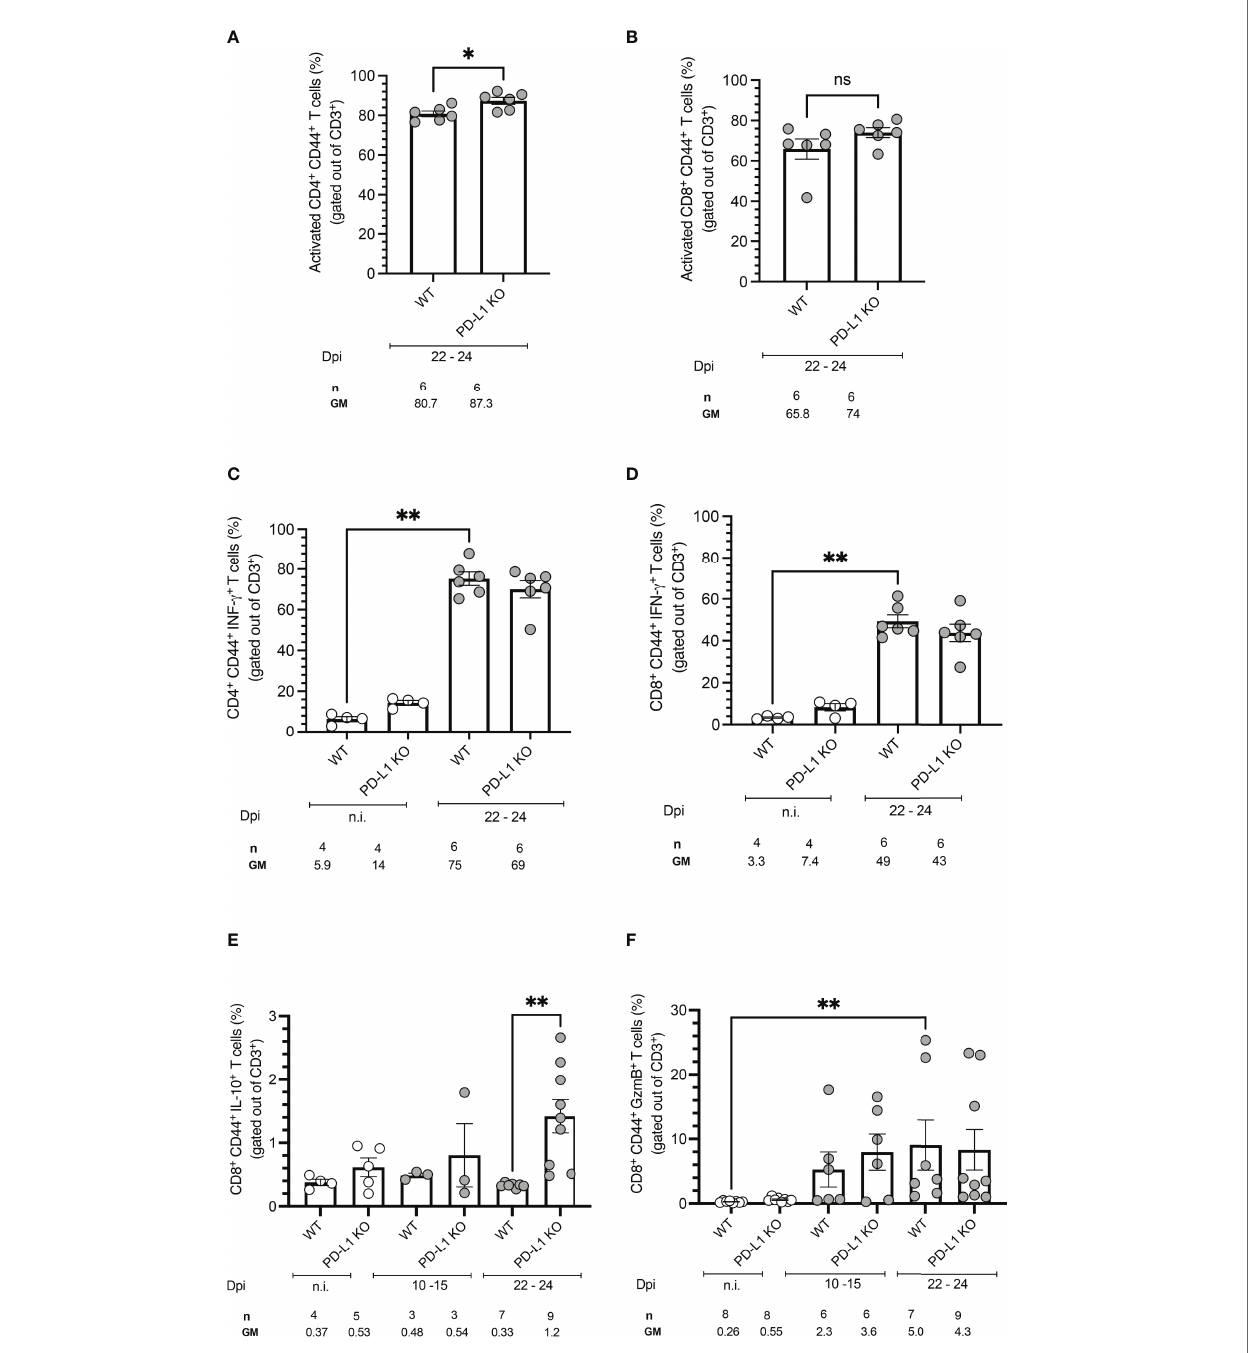
FIGURE 3 | PD-L1 de fi ciency does not affect activation, IFN- g production, or Granzyme B production but induces IL-10 secretion on CD8 + T cells after stimulation. Spleen cells were isolated from mice and analyzed by fl ow cytometry after a 5 h stimulation with PMA/Ionomycin. (A, B) PD-L1 de fi ciency does not affect T cell activation, de fi ned by CD44 expression, after T. cruzi infection on 22-24 dpi. (C, D) T. cruzi infection induces IFN- g on CD4 + and CD8 + T cells from WT and PD-L1 Ko mice. PD-L1 de fi ciency does not affect IFN- g production. (E) IL-10 is only induced at 22-24 dpi in CD8 + T cells from PD-L1KO Mice (F) Granzyme B is signi fi cantly upregulated only on CD8 + T cells from WT mice. PD-L1 de fi ciency does not affect Granzyme B production. Error bars indicate standard errors of the means (SEM). Data from two independent experiments. Under the graphs, n is the absolute number of mice used per time point, and the values below are the geometric means (GM). Data were analyzed for statistical signi fi cance using the Kruskal-Wallis test following Dunn´s multiple comparisons test. Asterisks denote P values as described in Methods; ns (not signi fi cant) was not plotted to avoid busy fi